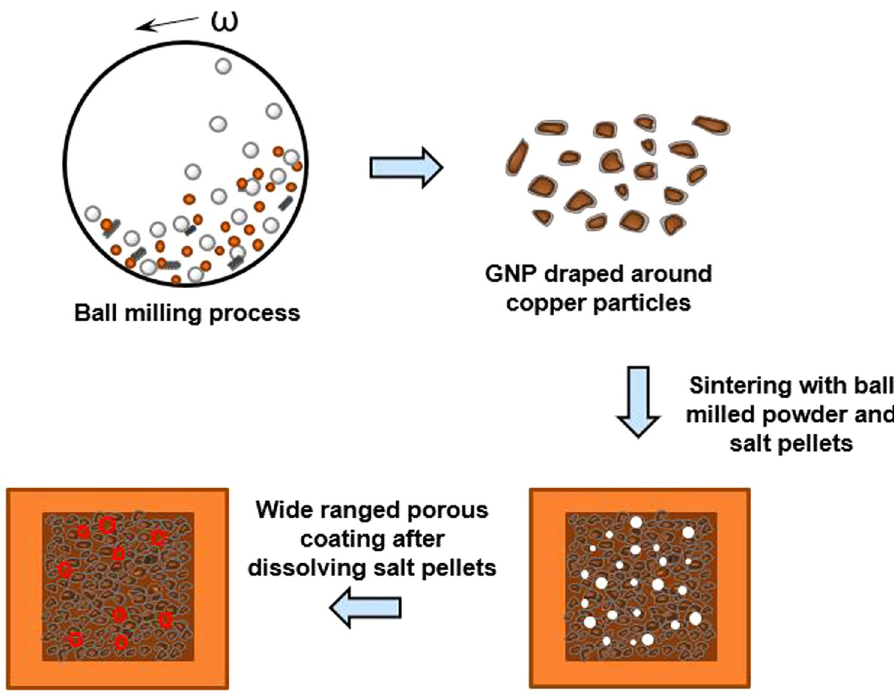
Figure 2. Schematic showing the development of coatings using salt templated sintering